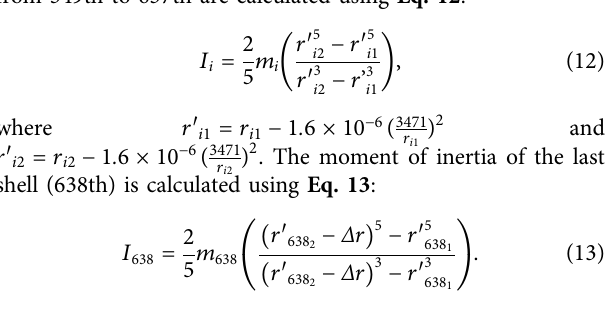
Frontiers in Earth Science |